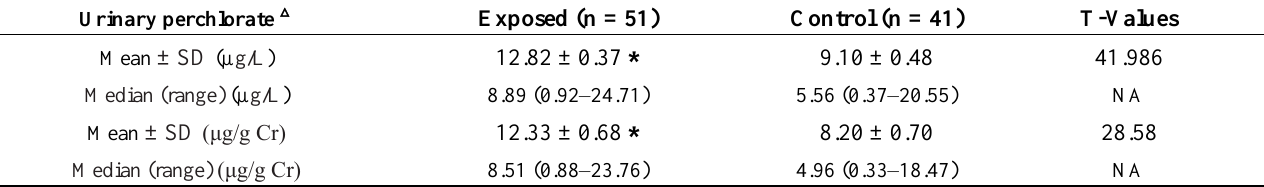
Table 3. Pre-shift mean and median values of urinary perchlorate concentrations of each group (unadjusted and adjusted by creatinine).